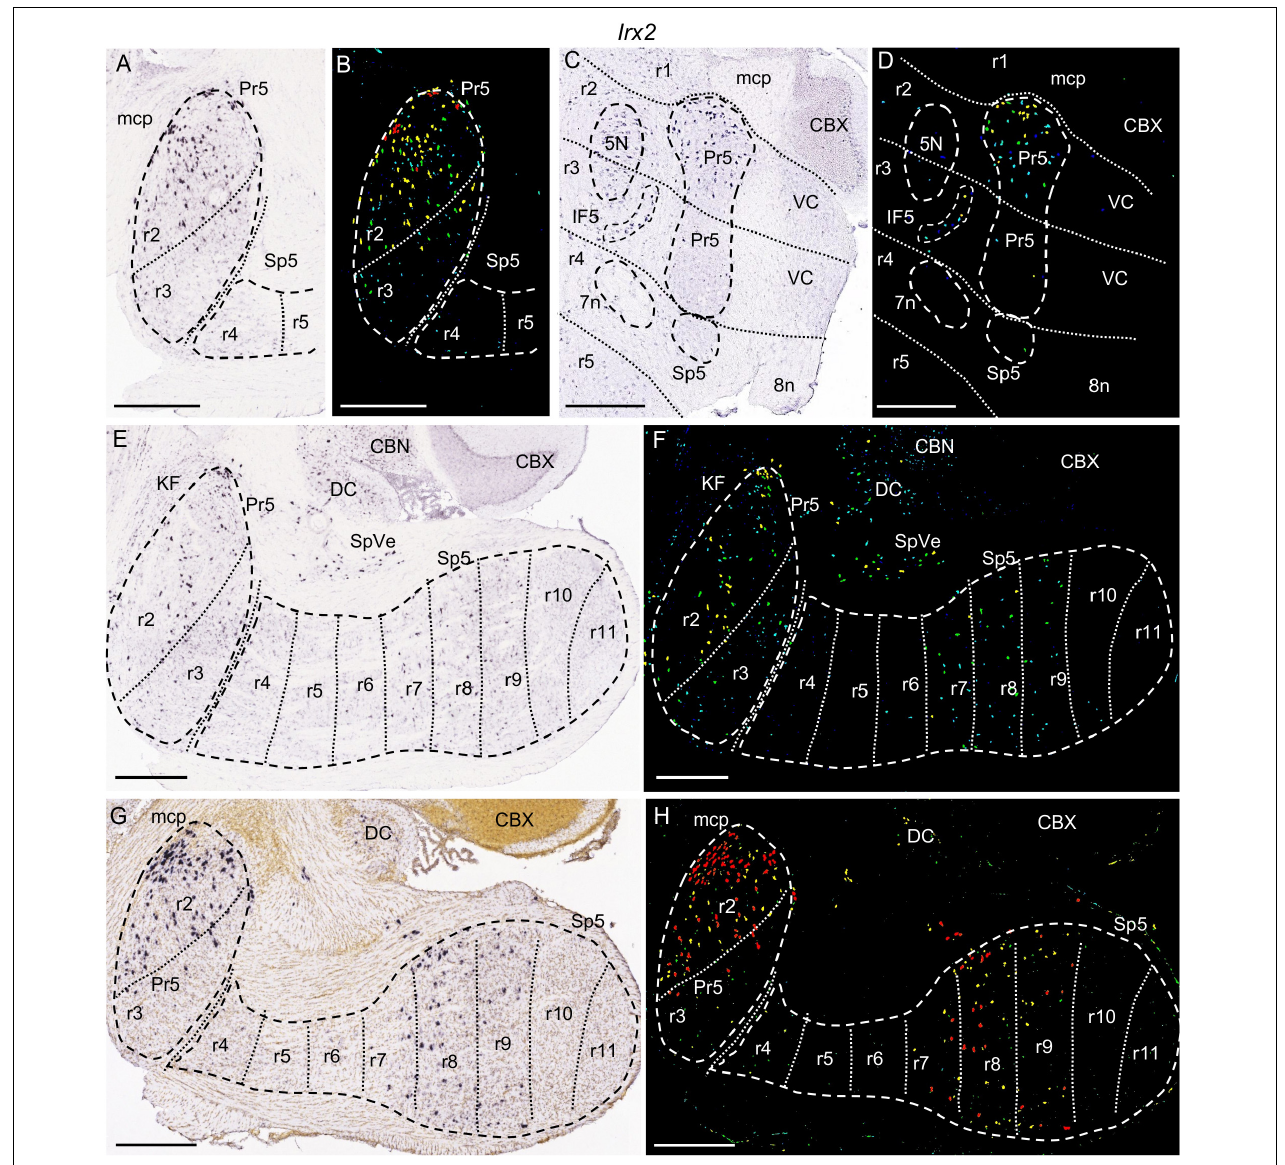
FIGURE 5 | Irx2 expression. In each image Pr5 and/or Sp5, as well as other structures indicated below, are, respectively, encircled by dashed lines. (A–D) Details of the expression pattern from an adult brain in Pr5, with its r2 portion expressing this gene, while r3 has only some positive cells. (A,B) Brightfield and color-coded images from a parasagittal section at lateral level. (C,D) Brightfield and color-coded images from a coronal section. R2 and r3 are delimited according to the position of 5N across both rhombomeres. 7n and 8n bundles determine the position of r4. Besides the r2 trigeminal portion, there is also expression in IF5. 5N, 7n, and IF5 are, respectively, encircled by dashed lines. (E,F) Brightfield and color-coded images from a parasagittal section, medial to the one shown in A. There is mild expression in the r2 and r3 trigeminal portions, with more positive cells in the former. Caudally, r7, r8, and r9 display some positive cells. (G,H) Brightfield and color-coded images from a parasagittal section of a P14 brain. The pattern is similar to the one shown for the adult in the former figures, but with higher intensity and a greater number of labeled cells in the positive zones (r2, r7, r8, and r9 portions of the trigeminal column). Scale bars = 500 µ